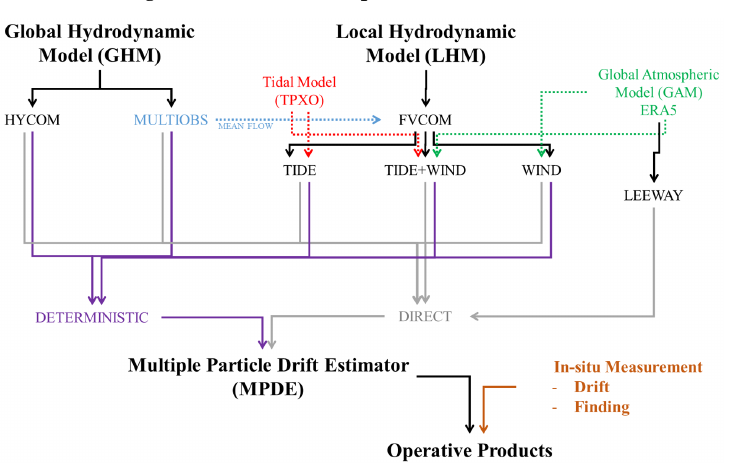
Figure 2. Process flow of the modeling scheme, including the data sources, hydrodynamic models, trajectory estimation methods, and operational